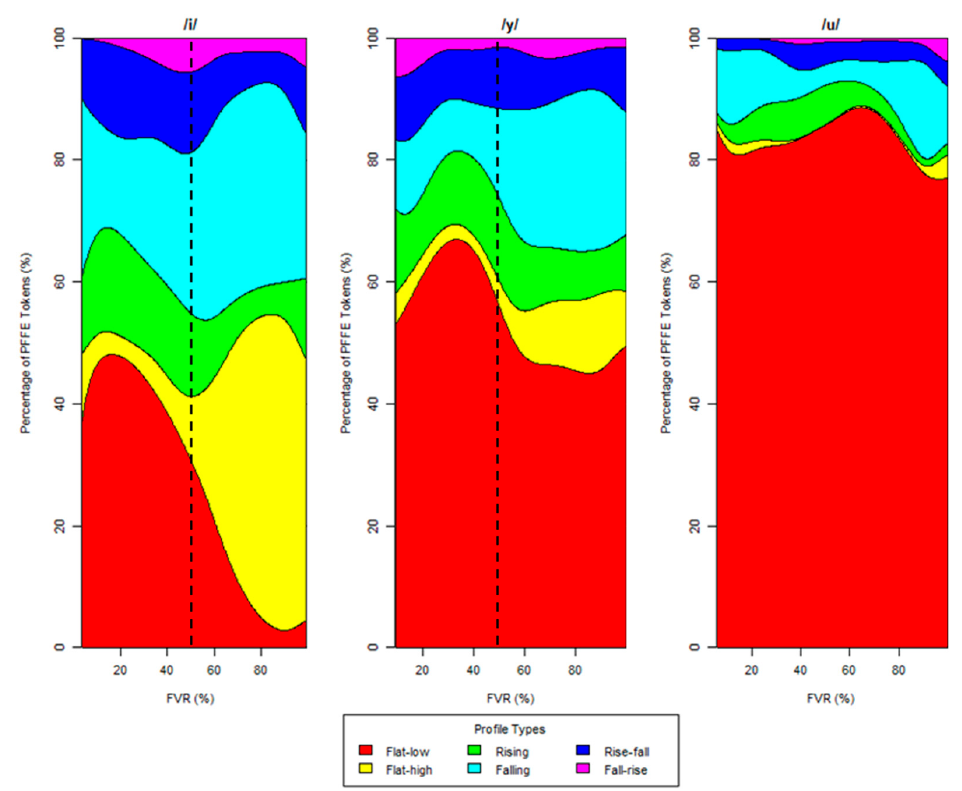
Figure 9. Profile types by vowel and FVR. Each plot shows the proportion of PFFE tokens belonging to each of the profile types at that combination of vowel and FVR. The dotted line at 50% indicates the approximate point at which the distributions of profile types for /i/ and /y/ shifted.